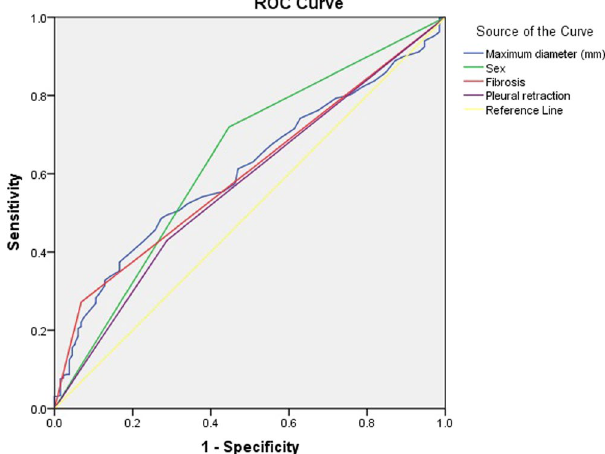
Figure 1. ROC curve for EGFR mutation in exon 19.